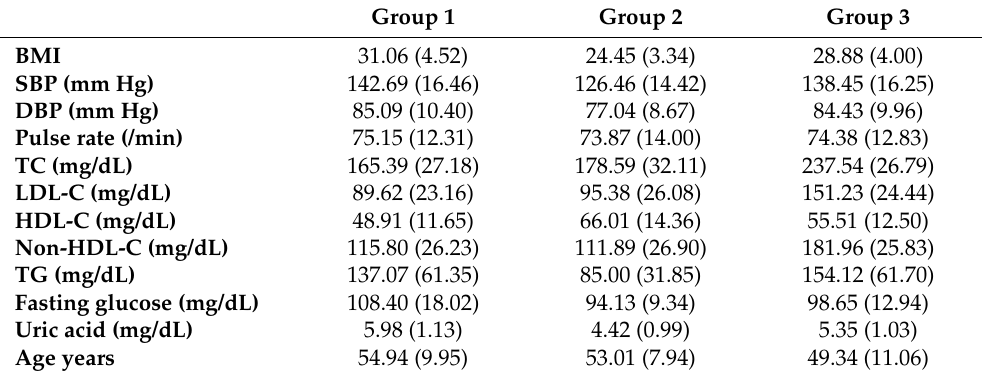
Table 1. Baseline characteristics (continuous variables) for the three groups yielded by cluster